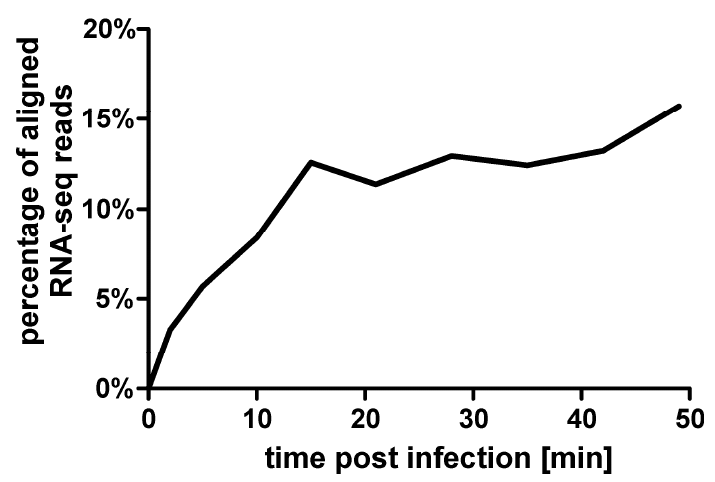
Figure 2. Percentage of RNA sequencing reads aligning to the φ R1 ‐ 37 phage genome at different time points post ‐ infection.